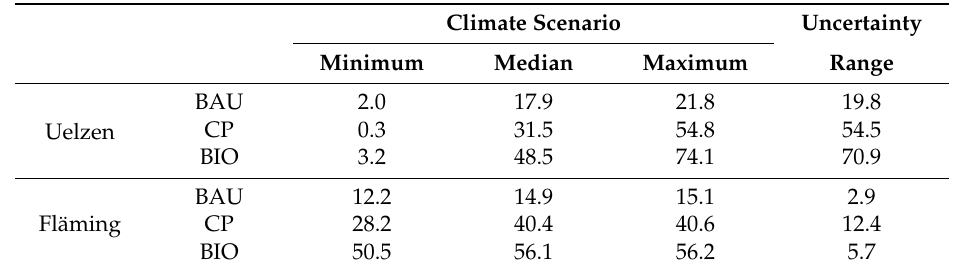
Table 5. Adaptation effort score (AES; see Section 2.5 for definition) under the forest management strategies business-as-usual (BAU), climate protection (CP) and biodiversity management (BIO) applying the climate scenarios of minimum, median and maximum run in Uelzen and Fläming. The uncertainty range is the difference between the AES values of the maximum and the minimum climate